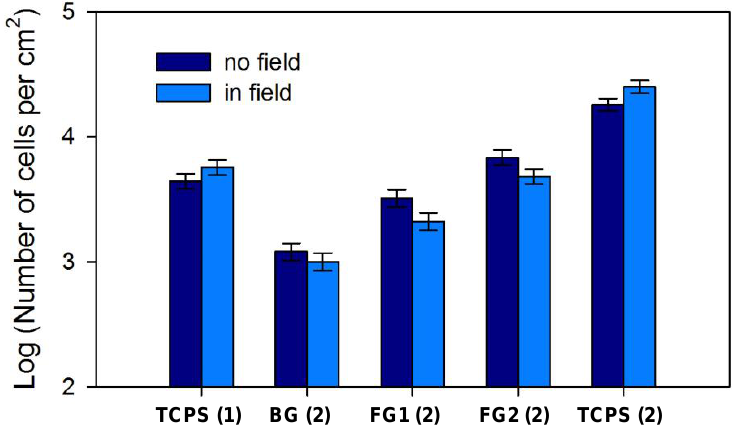
Figure 10. The effects of a magnetic field on the fibroblasts’ proliferation rate in different scaffolds. Data are presented as X ± m , n = 54 (9 fields of view per well ×6 wells). Label TCPS (1) corresponds to the proliferation of fibroblasts from donor #1, the numerical values are given in Table 2 (all 24 wells). All other labels correspond to the proliferation of fibroblasts from donor #2. A level of significance P < 0.05 was determined for FG1 (2), FG2 (2), and TCPS (2).